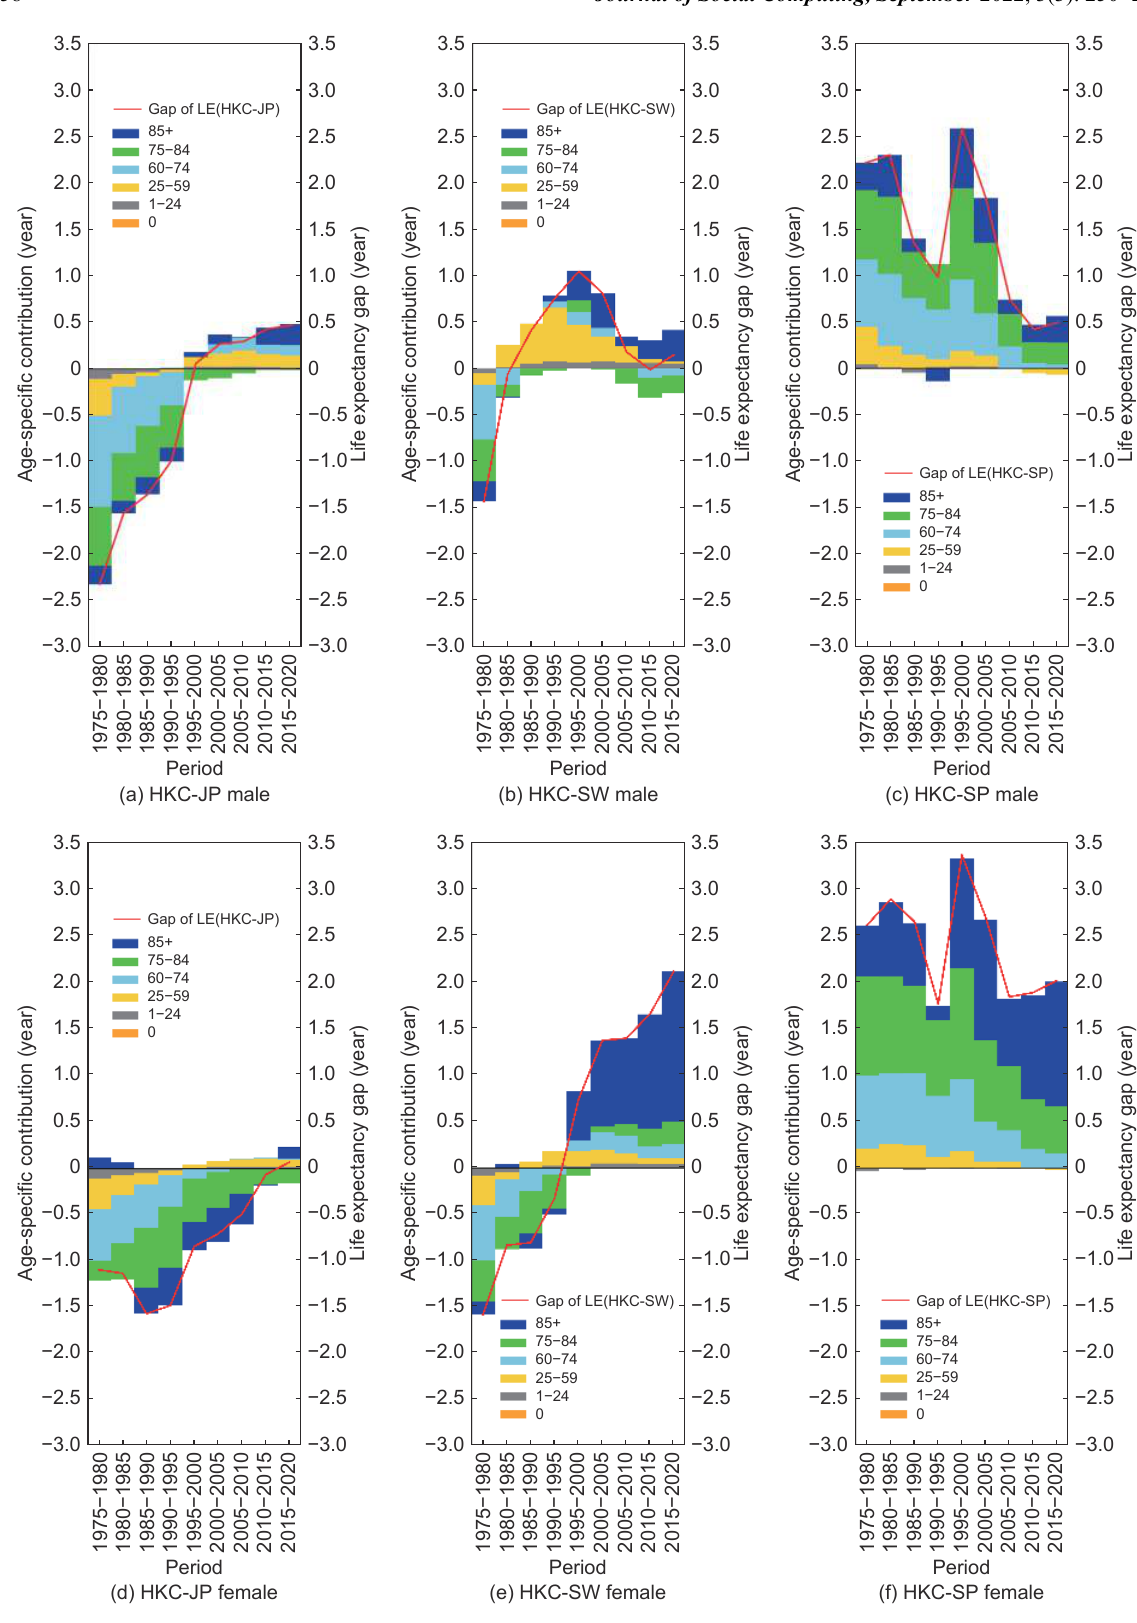
Fig. 3 Effect of mortality rates of different ages on life expectancy comparison of the HKC-JP, HKC-SW, and HKC-SP cases, for male and